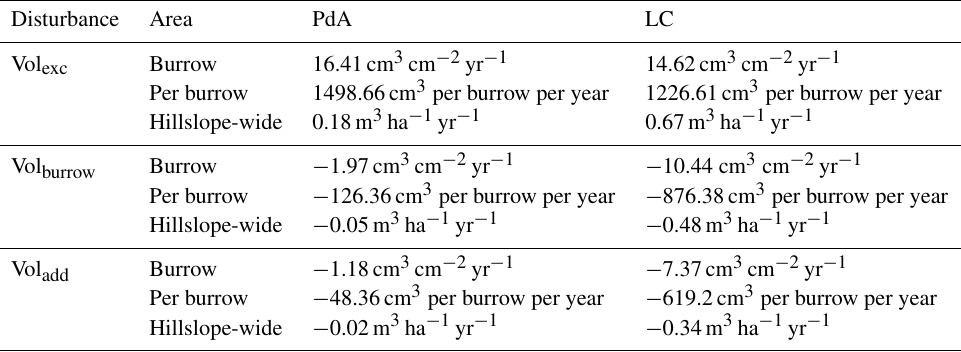
Table A3. Summary of the volume of redistributed sediment according to area and disturbance type. Vol exc describes the volume of the sediment excavated by the animals. Vol burrow describes the volume of the sediment redistributed during rainfall events within burrows. Vol add describes the difference in redistributed sediment volume within burrows and the burrow-embedded area during rainfall.